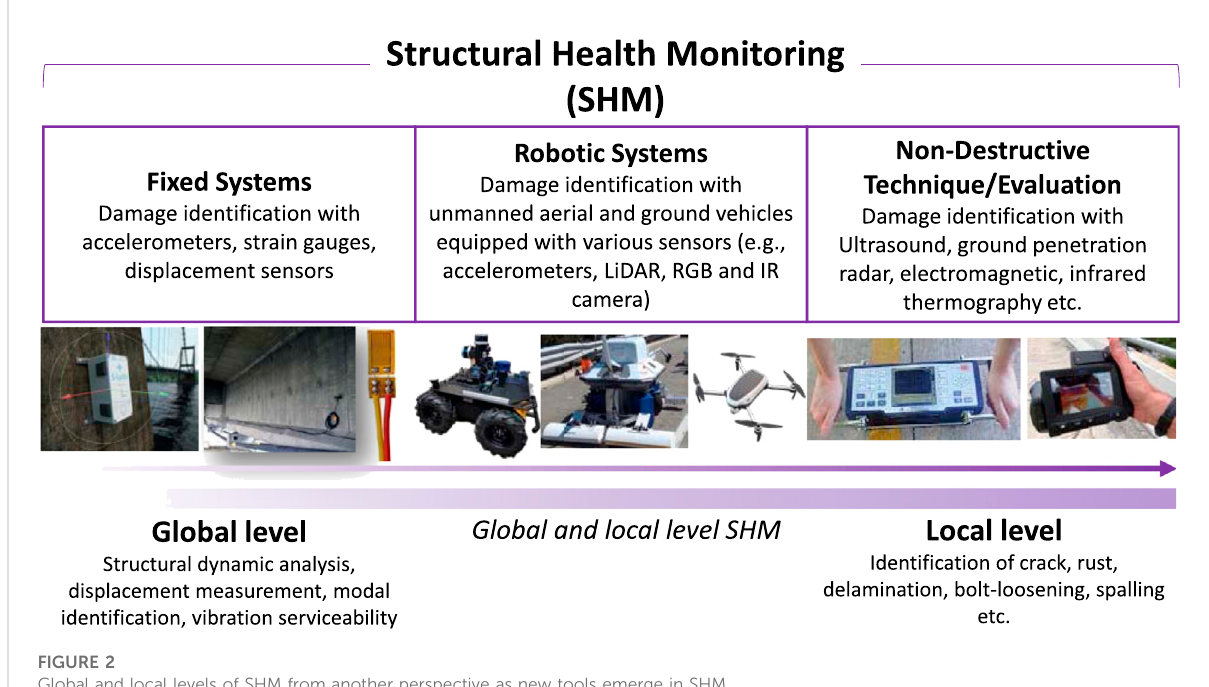
FIGURE 2 Global and local levels of SHM from another perspective as new tools emerge in